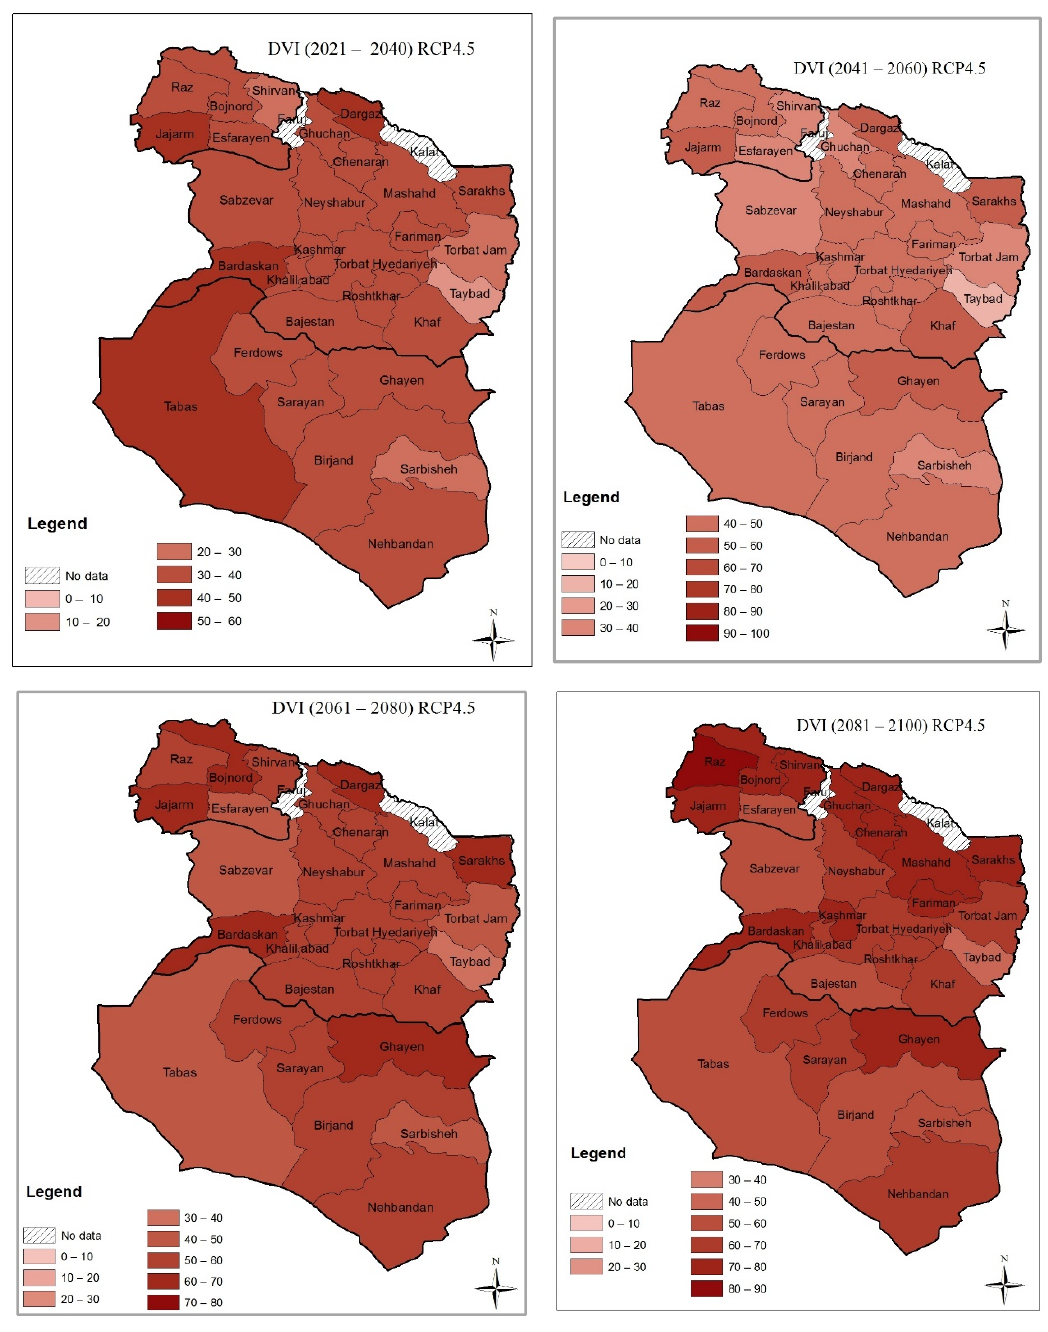
Figure 8. Drought vulnerability index for the 2030s, 2050s, 2070s, and 2090s under RCP4.5 scenarios. Counties with white hachure show lack of data.